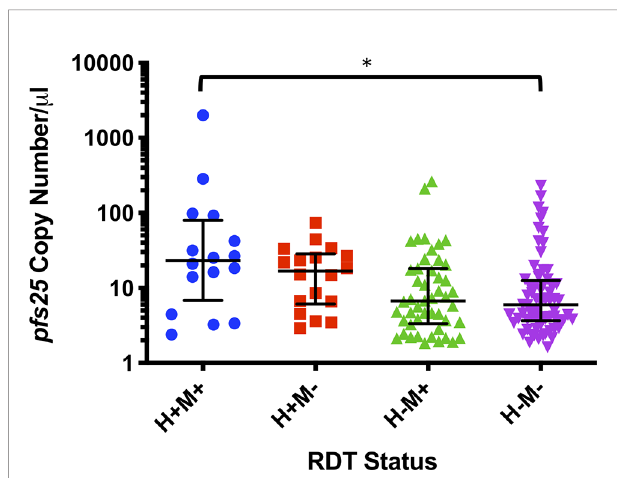
FIGURE 2 | pfs25 copy number/µl by combined HIV RDT (H) and malaria rapid diagnostic test (RDT) (M) status. Data are represented as medians and interquartile ranges and were analyzed by Dunn ’ s multiple comparisons test, *P ≤ 0.05.